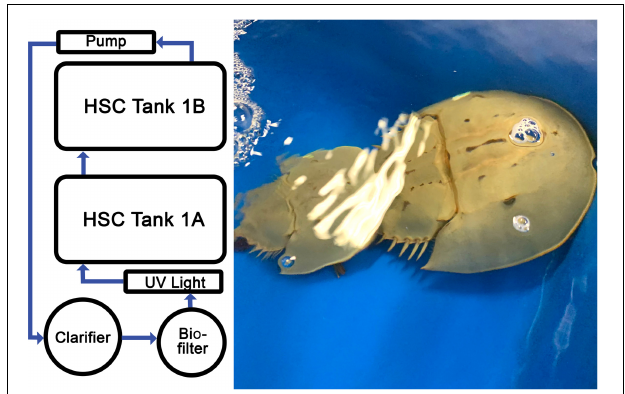
FIGURE 2 | Recirculating aquaculture system (RAS). Temperature-controlled, saltwater system optimized for HSC aquaculture comprising multiple tanks, filtration units, UV sterility lights, and aeration system. Photograph of two HSCs in the RAS engaging in typical breeding